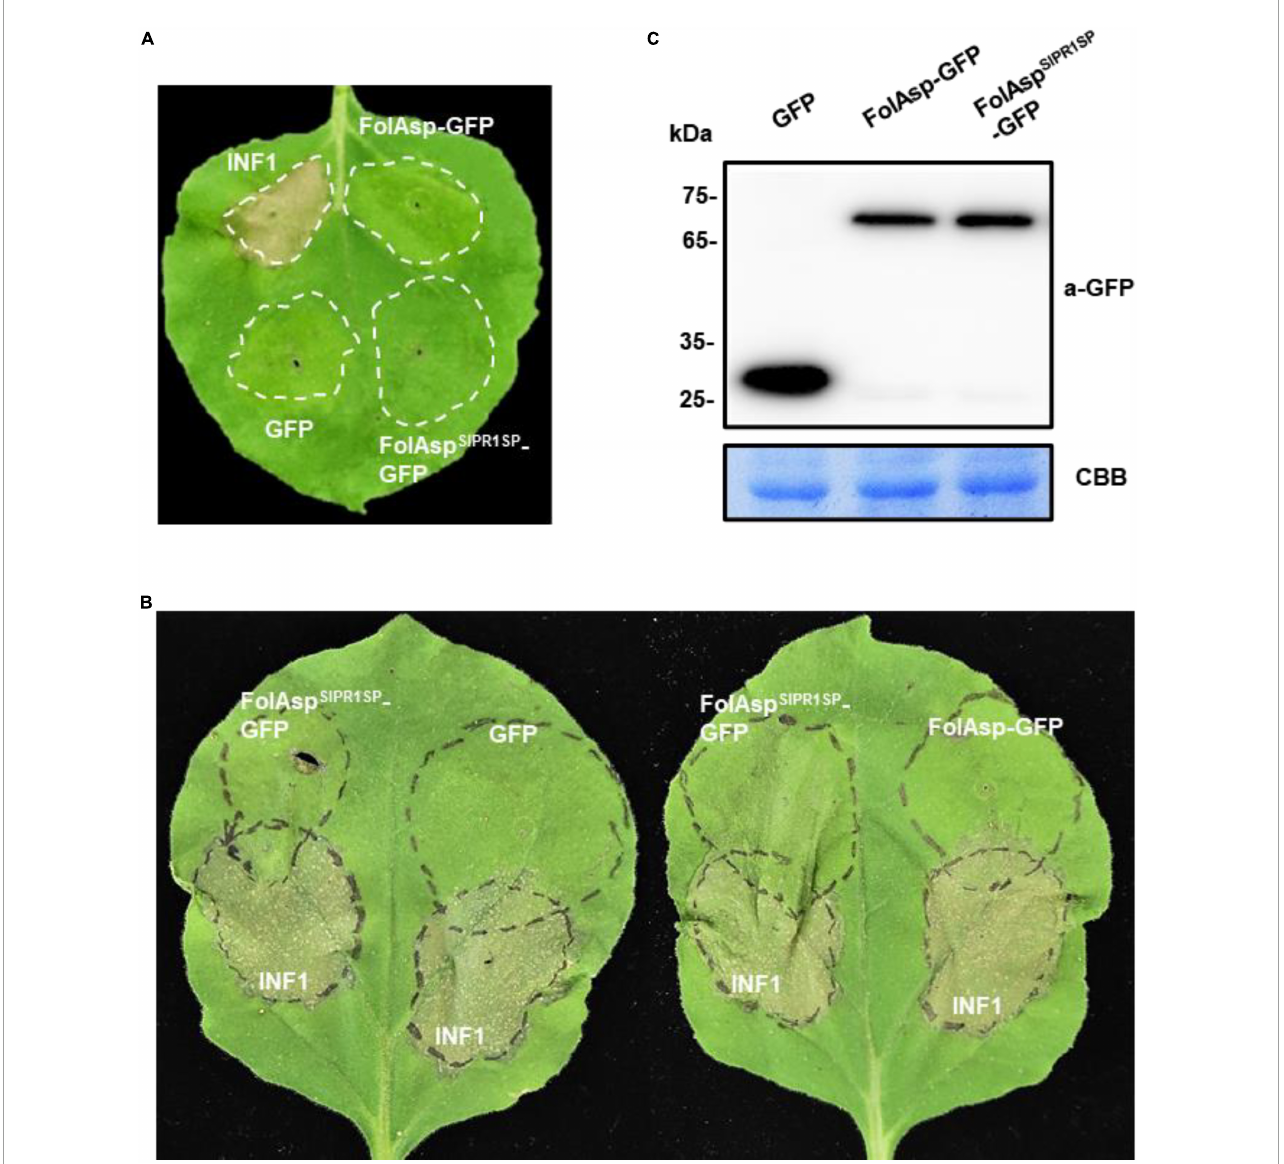
FIGURE5 FolAsp inhibits INF1-mediated cell death. (A) Validation of FolAsp in induced cell death in N. benthamiana. Leaves were with agroinfiltration expressing GFP, FolAsp-GFP, and FolAsp SlPR1 SP -GFP, or the cell death inducer INF1. Photographs were taken 3 DAI. (B) FolAsp is involved in suppression of cell death. Representative leaves showed cell death induced by transient expression of INF1 in N. benthamiana leaves pretreated with agroinfiltration expressing GFP, FolAsp-GFP, or FolAsp SlPR1 SP -GFP for 2 days. The INF1-infiltrated leaves were photographed at 60 HAI. (C) Protein expression at 2